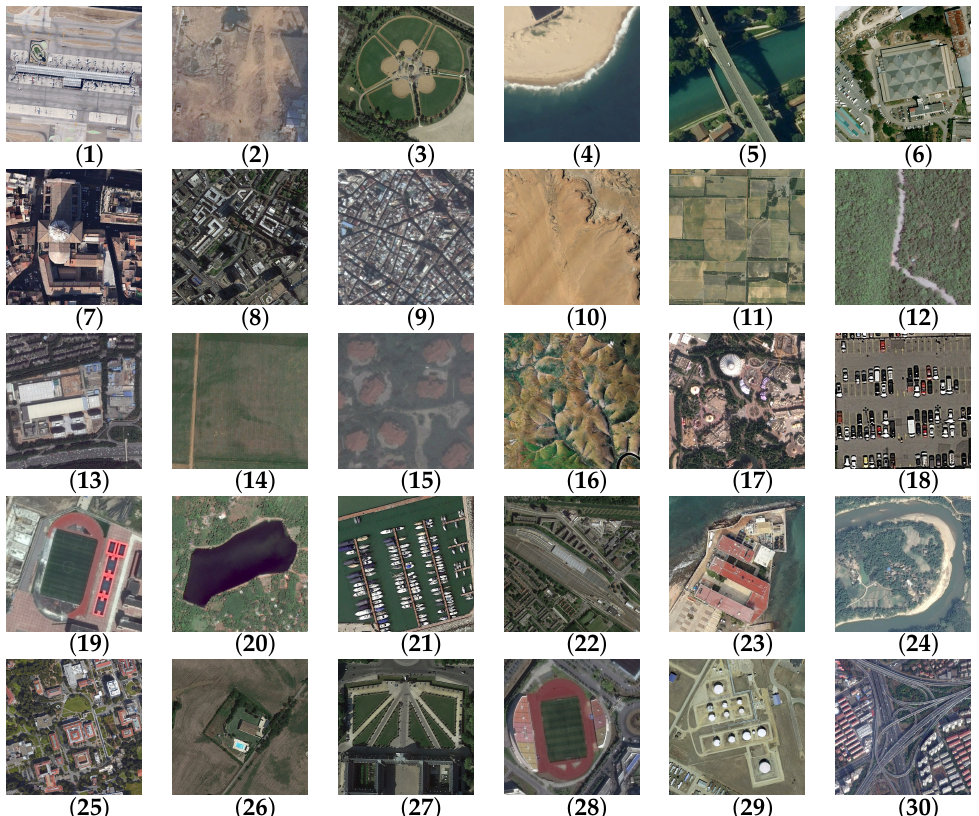
Figure 4. Sample images of the AID dataset: ( 1 ) Airport, ( 2 ) Bare land, ( 3 ) Baseball field, ( 4 ) Beach, ( 5 ) Bridge, ( 6 ) Center, ( 7 ) Church, ( 8 ) Commercial, ( 9 ) Dense residential, ( 10 ) Desert, ( 11 ) Farmland, ( 12 ) Forest, ( 13 ) Industrial, ( 14 ) Meadow, ( 15 ) Medium residential, ( 16 ) Mountain, ( 17 ) Park, ( 18 ) Parking lot, ( 19 ) Playground, ( 20 ) Pond, ( 21 ) Port, ( 22 ) Railway station, ( 23 ) Resort, ( 24 ) River, ( 25 ) School, ( 26 ) Sparse residential, ( 27 ) Square, ( 28 ) Stadium, ( 29 ) Storage tanks, ( 30 )